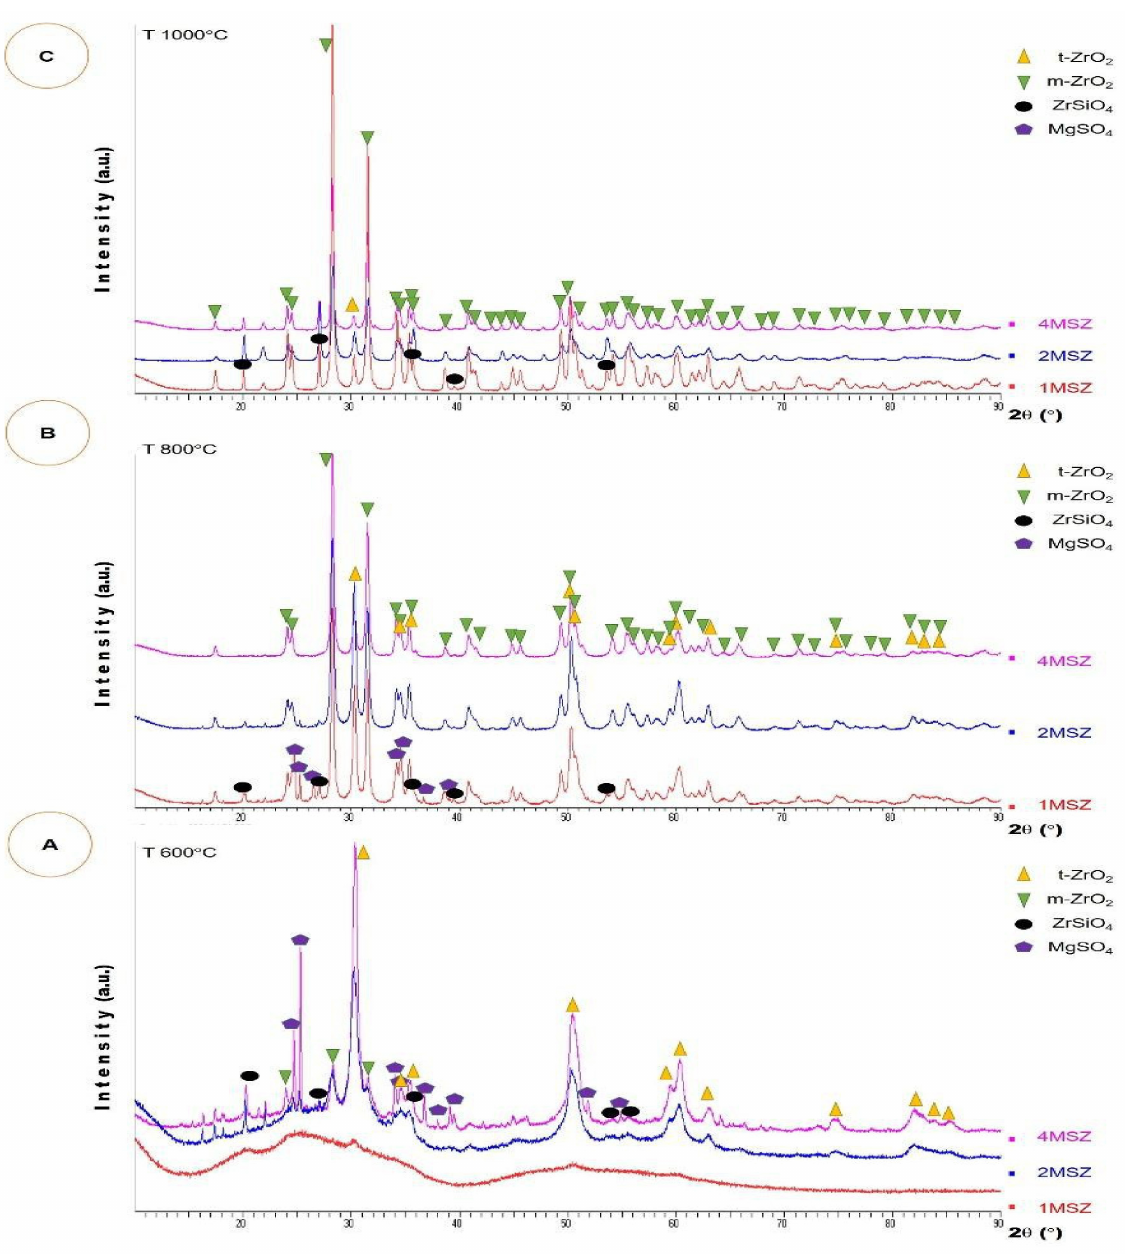
Figure 3. The XRD Diffractograms of all MSZ samples at elevated calcination temperatures. ( A ) 600 ◦ C, ( B ) 800 ◦ C and ( C ) 1000 ◦